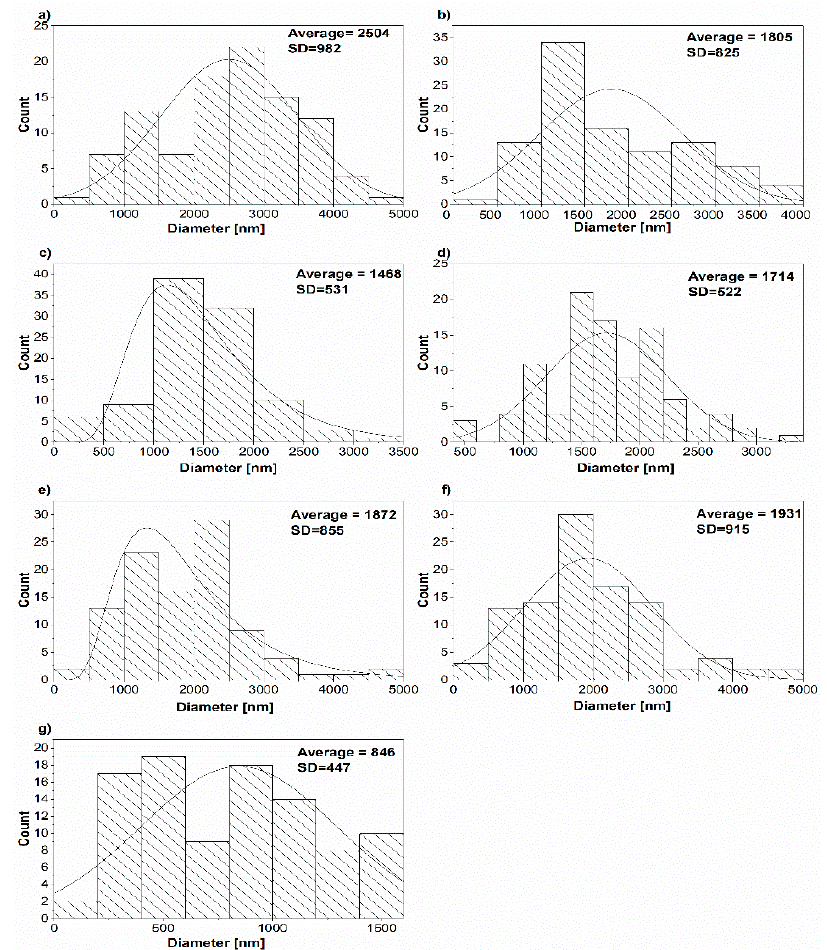
Figure 3. Histograms of the prepared samples: ( a ) Pure EVA, ( b ) EVA/0.1 wt % MWCNTs, ( c ) EVA/1.0 wt % MWCNTs, ( d ) EVA/1.5 wt % MWCNTs, ( e ) EVA/2.0 wt % MWCNTs, ( f ) EVA/2.5 wt % MWCNTs, and ( g ) EVA/3.0 wt % MWCNTs.